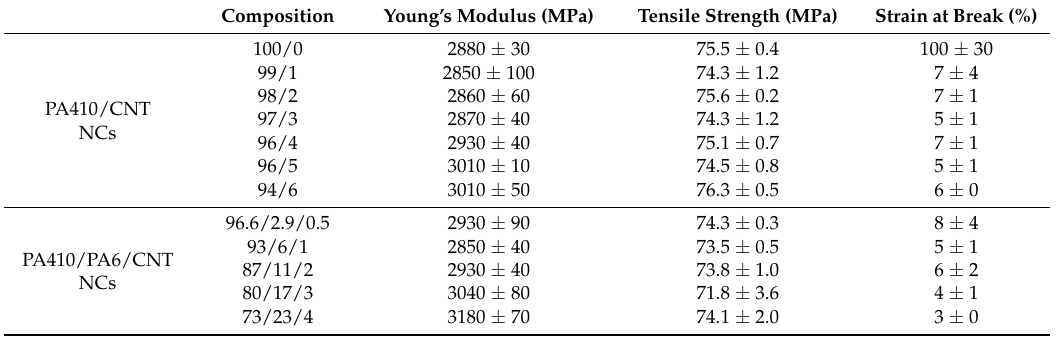
Table 6. Young’s modulus, tensile strength and ductility values of PA410/CNT and PA410/PA6/CNT NCs.